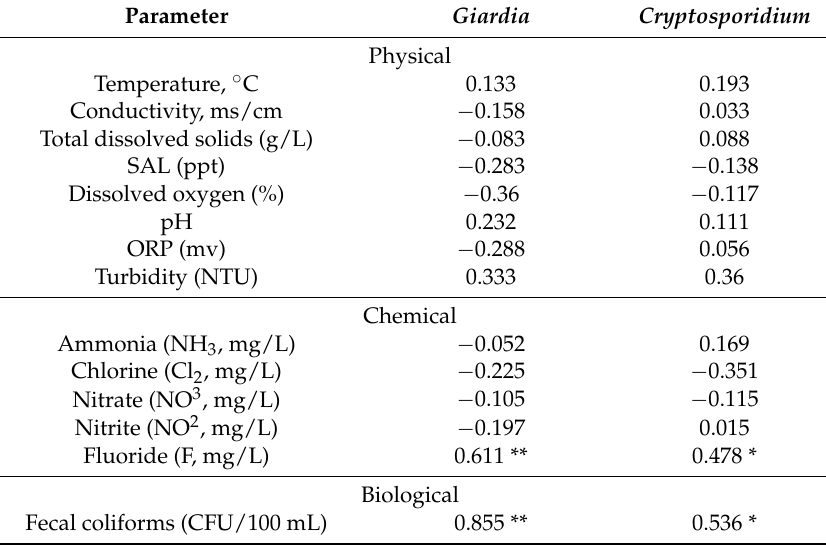
Table 5. Correlation analysis between Giardia and Cryptosporidium with physical, chemical and biological